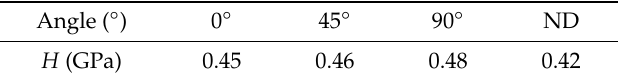
Table 1. Fitting values of hardness under di ff erent angles.